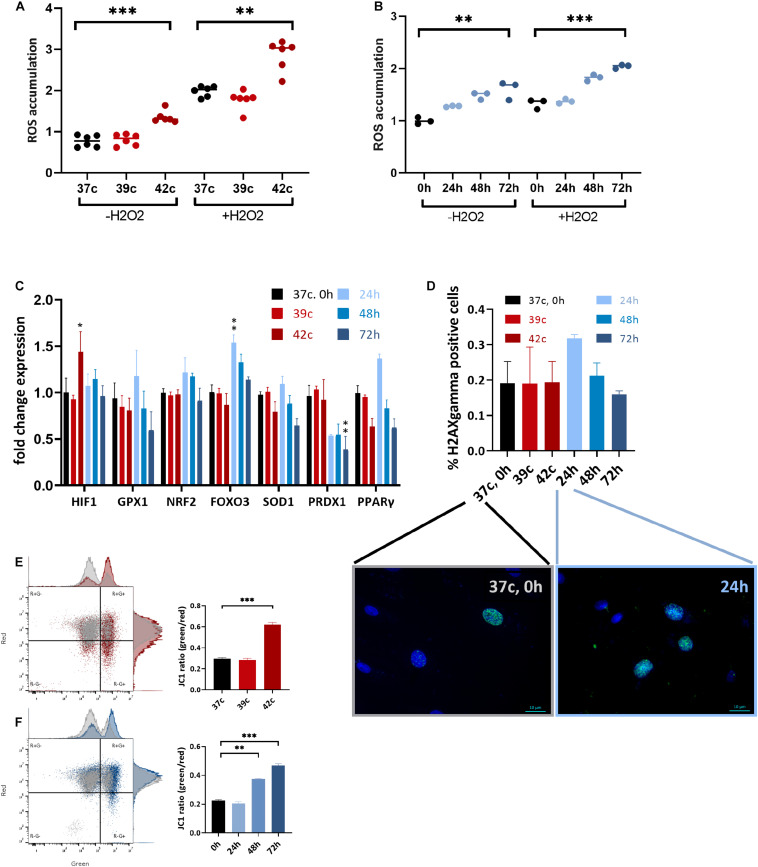
Change in metabolic function following HS in bUC-MSCs. Flow cytometry results of CellROX staining for (A) cellular ROS levels after pulse HS without and with 500 μM H2O2 for 30 min. (B) cellular ROS levels after constant HS without and with 500 μM H2O2 for 30 min. Data presented are a mean of green fluorescence, ±SD n = 6. (C) Change in expression levels of oxidative stress response pathway genes. All genes were normalized to control bUC-MSCs. Statistical significance was determined using the Bonferroni–Sidak method, and results represent the mean ± SEM, n = 4. (D) Histone H2AX phosphorylation was measured by fluorescent microscopy imaging with anti-γH2AX (green) and DAPI staining for nucleic acid (blue), scale bars = 10 μm. Negative and positive nuclei were counted (∼200 from each slide) from two unrelated experiments, mean ± SEM are shown. (E) Membrane potential was measured using JC-1 assay and flow analysis (see example in the left panels). Percent of red cells (upper left, R+G–) declined after pulse HS (red) and (F) constant HS (Blue) as compared to the untreated cells (gray), n = 3. Statistics: two-way ANOVA with Benjamini, Krieger, and Yekutieli post hoc test as compared to 37°C, 0 h, **p < 0. 01, ***p < 0.001.